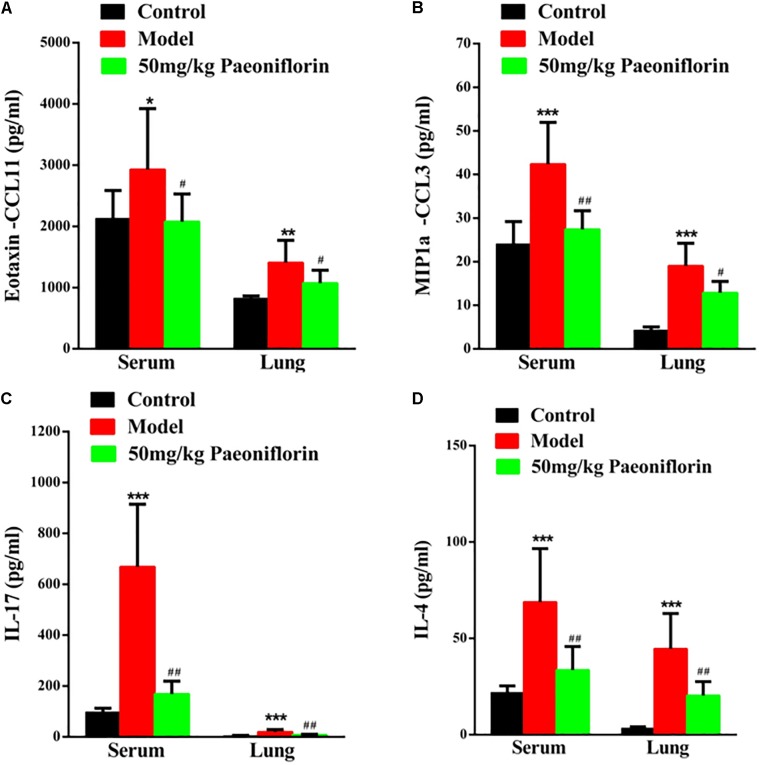
Paeoniflorin reduces chemokines and cytokines in allergic asthma mice. The level of exotaxin in serumand lung tissue (A), the level of MIP-1α in serum and lung tissue (B), the level of IL-17 in serum and lung tissue (C), and the level of IL-4 in serumand lung tissue (D). The data were expressed as the mean ± SD. ∗Means control group vs model group (∗p < 0.05, ∗∗p < 0.01, and ∗∗∗p < 0.001); #Means model group vs paeoniflorin group (#p < 0.05, ##p < 0.01, and ###p < 0.001).